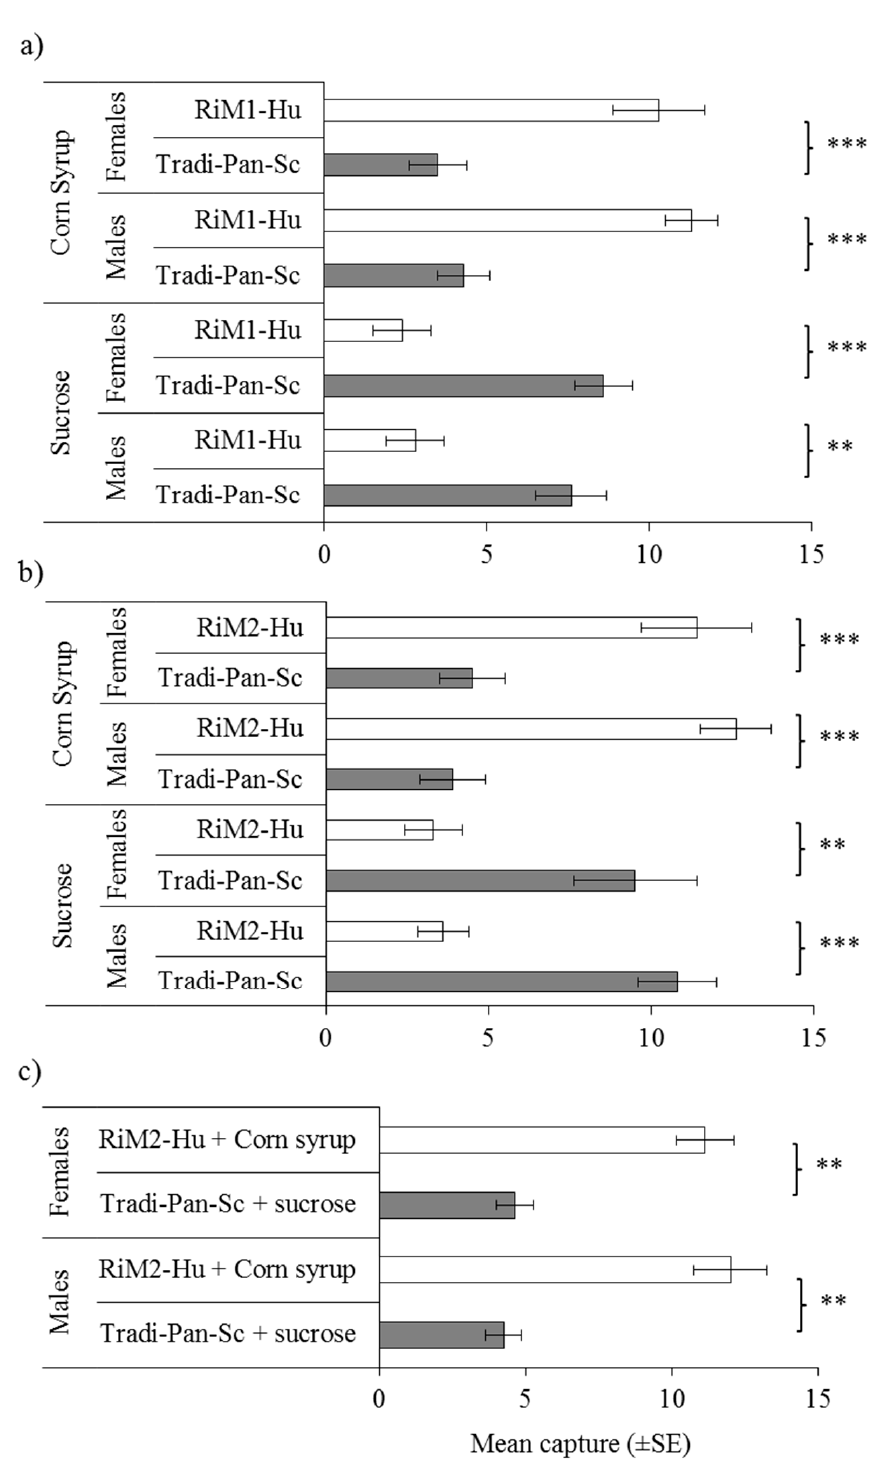
Figure 3. Mean numbers of trapped males and females in pairwise comparisons of raspberry-isolate yeasts ( a ) Hanseniaspora uvarum , RiM1-Hu and ( b ) H. uvarum , RiM2-Hu with the reference baker’s yeast Saccharomyces cerevisiae (Tradi-Pan-Sc) grown in sucrose or corn syrup, or ( c ) H. uvarum , RiM2-Hu grown in corn syrup compared with S. cerevisiae (Tradi-Pan-Sc) grown in sucrose. ** denotes significant difference p < 0.01; *** p < 0.001, (paired t -test).